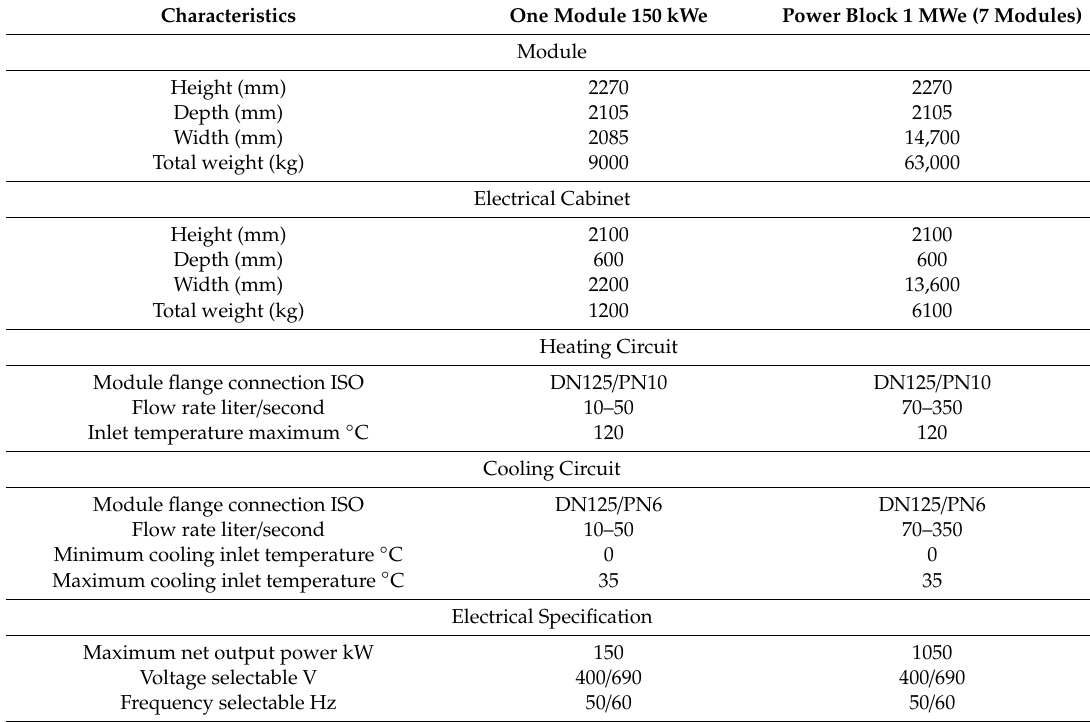
Table 1. Basic technical characteristics of small-size compact Climeon heat power converters